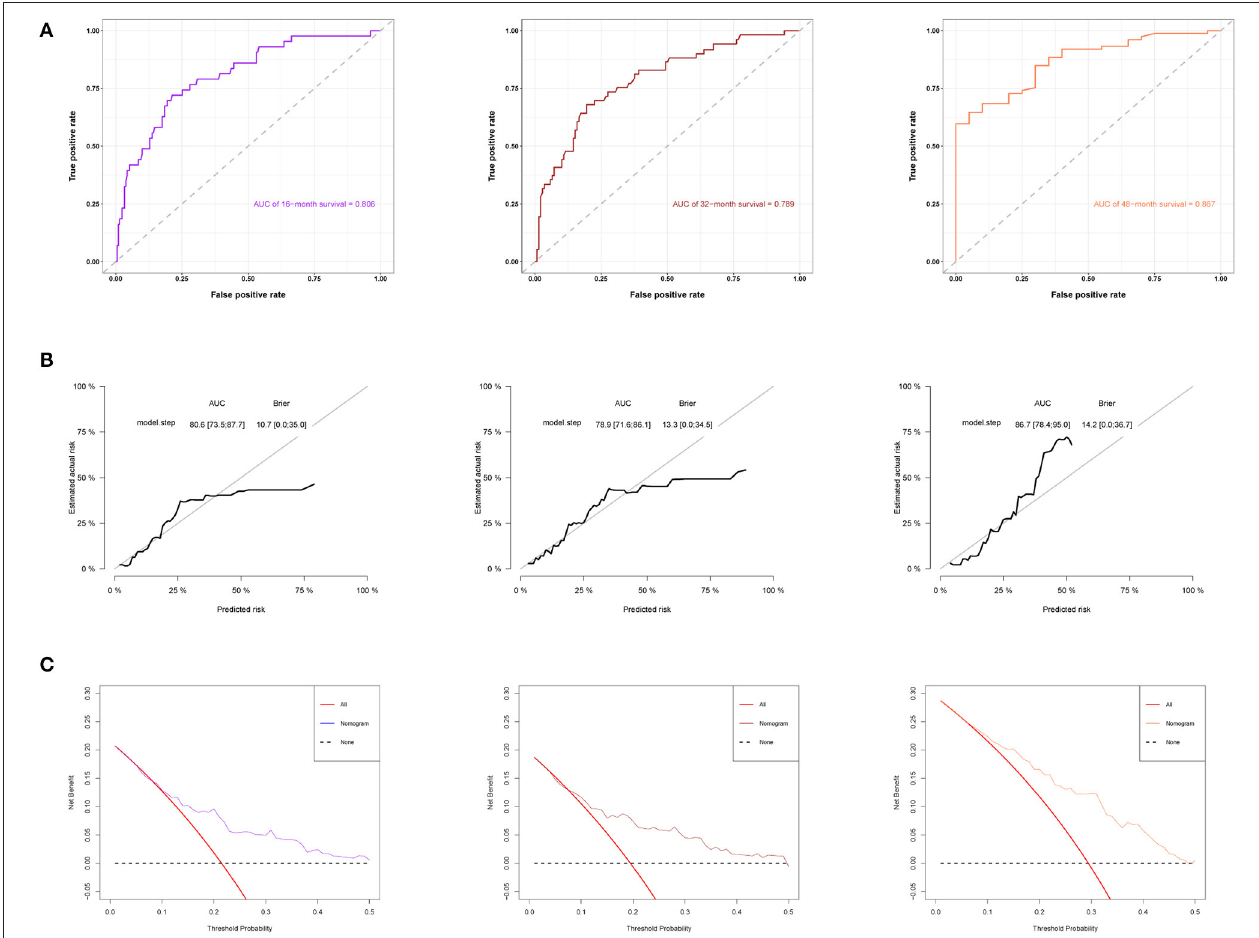
FIGURE 5 | Model discrimination and performance in the validation set. (A) ROC curves for nomogram-based prognostic prediction. (B) Calibration curve of 16-, 32-, and 48-month specific survival. (C) DCA of this nomogram in the validation set.